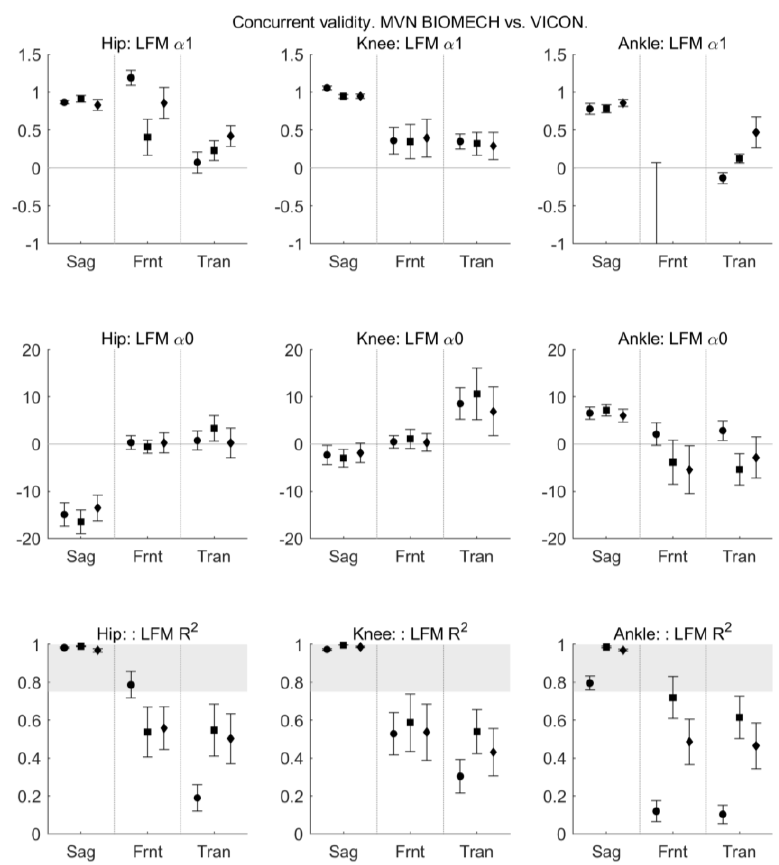
Figure 10. The outcome parameters of linear fit method comparing MVN BIOMECH and VICON data. Outcome parameters are α 1 (scaling factor; top row ), α 0 (scalar addition; middle row ) and R 2 (strength of the linear relation between the two signals; bottom row) for the hip ( left ), knee ( centre ) and ankle ( right ) joints in the sagittal (Sag), frontal (Frnt) and transverse (Tran) planes of movement. The three data points in each plane correspond to the walk (left-most point; circle), squat (centre point; square) and jump (right-most point; diamond) tasks. Error bars indicate 95% confidence intervals.